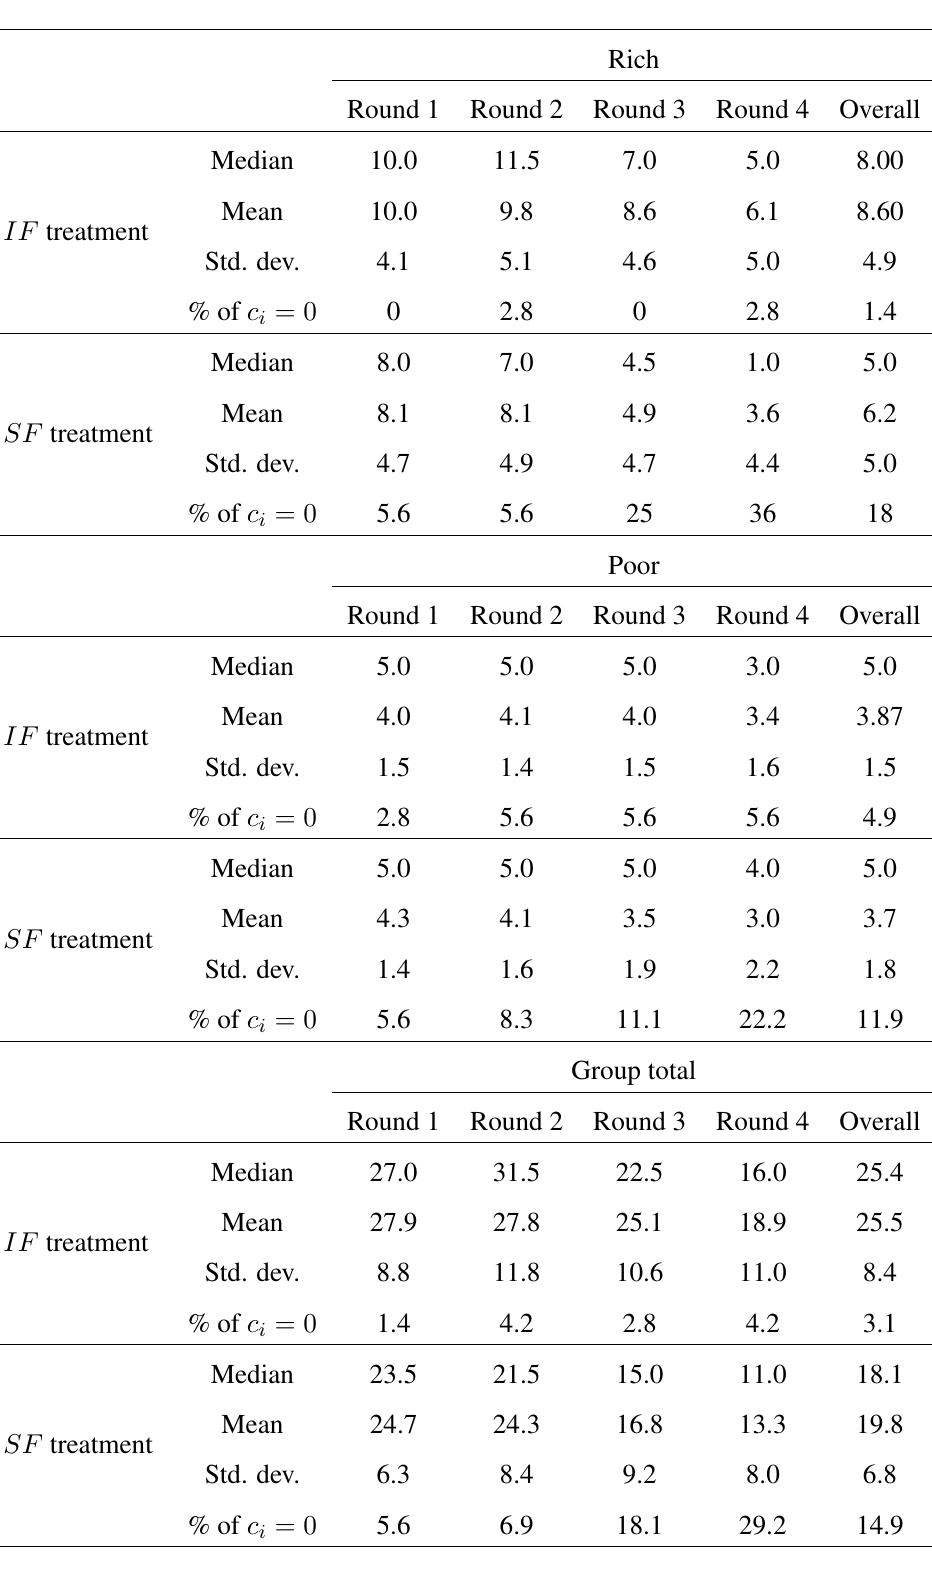
Table 1 . Summary statistics on contributions in the two